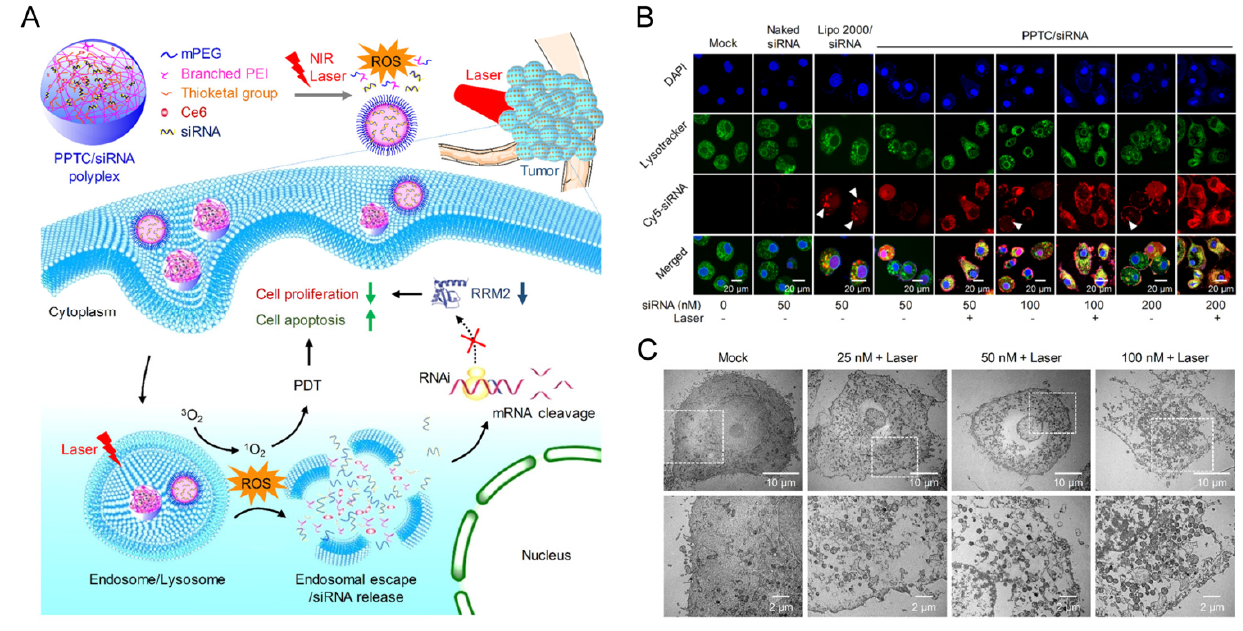
Figure 4. ( A ) Illustration of the ROS-activatable PPTC/siRNA polyplex co-delivering ce6 and siRNA. ( B ) CLSM images of HepG2-Luc cells after coincubation with different concentration of PPTC/siRNA for 4 h with or without laser irradiation (0.1 W/cm 2 , 2 min). ( C ) TEM image analysis after HepG2-Luc cells were treated with PPTC/siRNA polyplex and irradiated with 660 nm laser (0.1 W/cm 2 , 2 min). Reprinted with permission from [97]. Copyright 2020 American Chemical